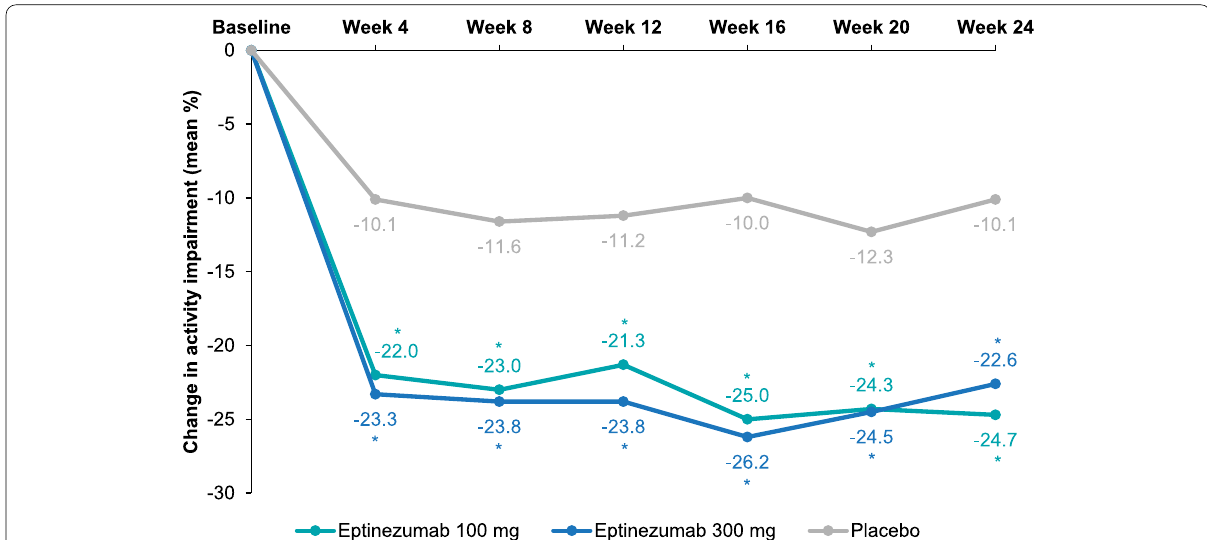
Fig. 4 Mean Changes From Baseline in WPAI:M Activity Impairment Subscores. Mean changes from baseline were calculated using LSMeans from a mixed model for repeated measures. The model included the following fixed effects: visit, country, stratification factor (monthly headache days at baseline: 14/> 14) and treatment as factors, baseline WPAI:M activity impairment subscore as a continuous covariate, baseline score-by-visit ≤ interaction, treatment-by-visit interaction, and stratum by-visit interaction. * P < 0.0001 vs placebo. WPAI:M, Work Productivity and